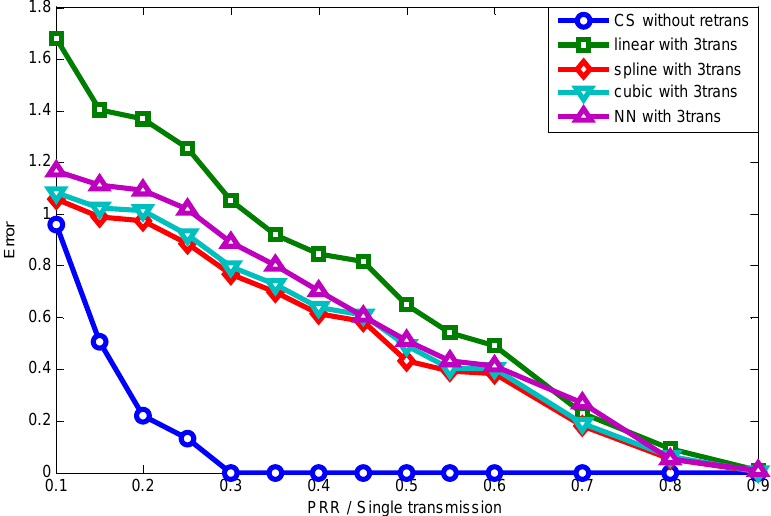
Figure 15. Reconstruction error